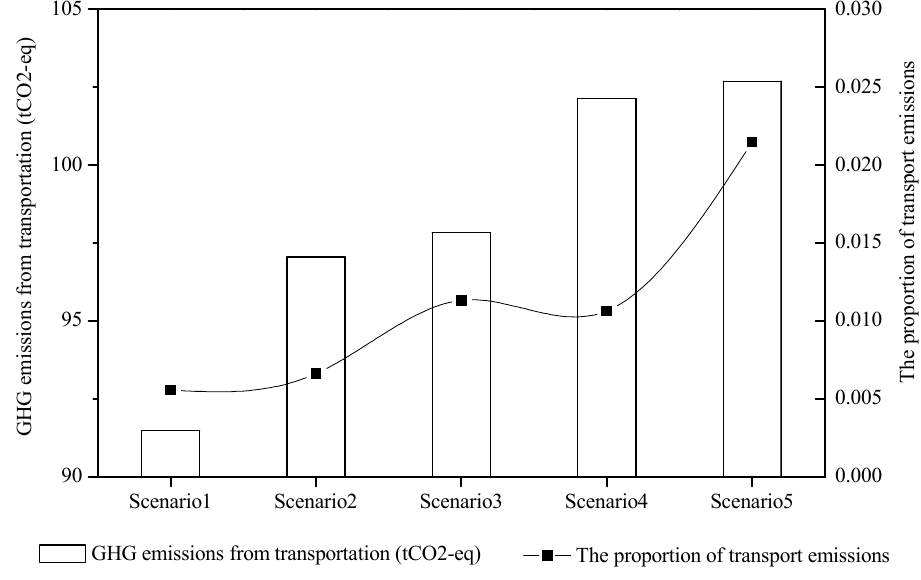
Figure 13. GHG emissions from MSW transportation and its proportion of total emissions.